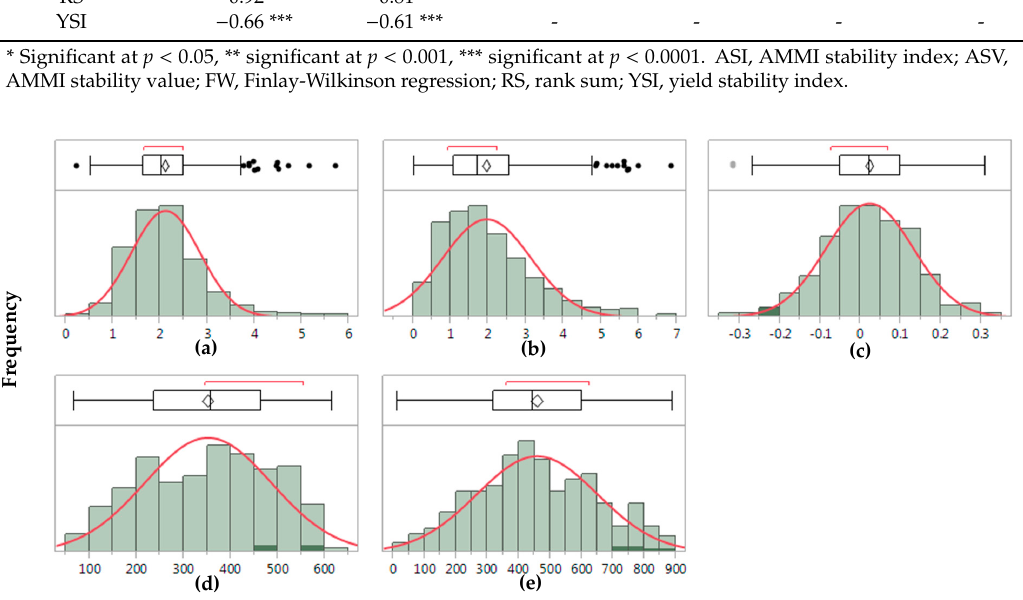
Figure 2. Frequency distribution and boxplots for the trait stability indices for grain yield. ( a ) ASI, AMMI stability index; ( b ) ASV, AMMI stability value; ( c ) FW, Finlay-Wilkinson regression; ( d ) RS, Table 3. Spearman’s Rank correlation coefficient ( ρ ) between trait values and stability indices. Trait values were represented as adjusted and genomic estimated breeding values (GEBV).